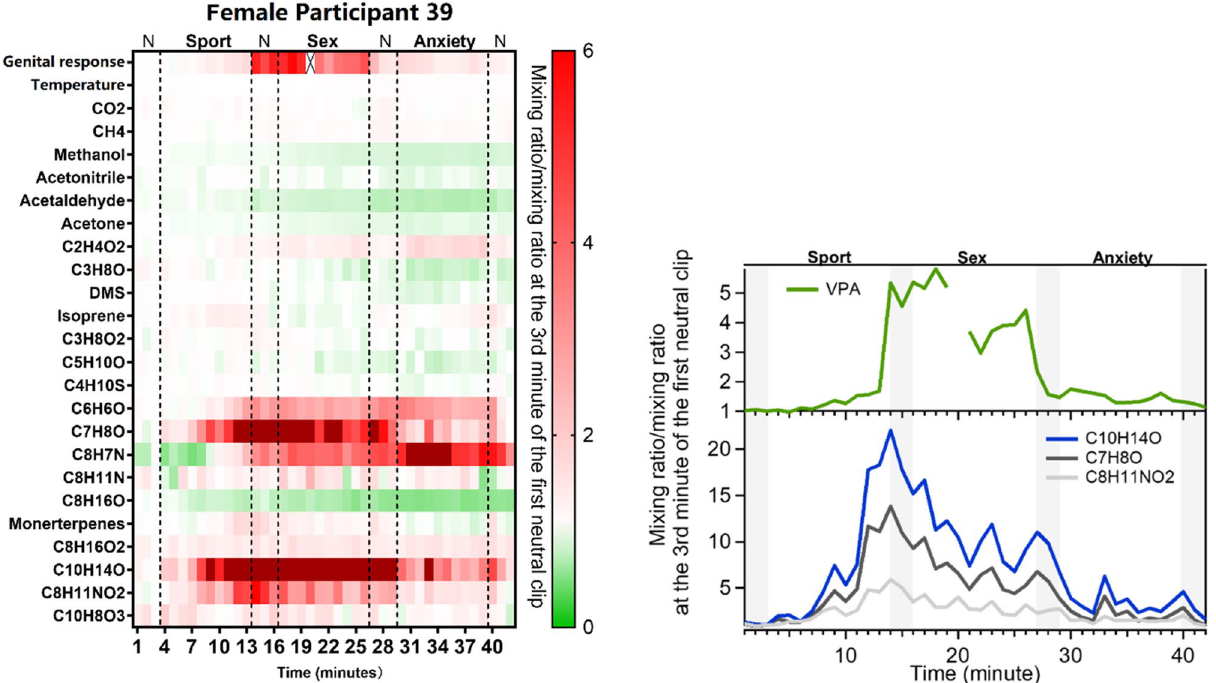
Figure 4. Heat plot of breath compounds together with genital response (vaginal pulse amplitude, VPA) and temperature (clitoris) of female volunteer No. 39 over the experimental time (upper figure), and time series of selected VOCs having large variations (lower figure). The cross in the heat plot indicates data over that minute was not available. Shaded area on the right plot represents the time when neutral clips were